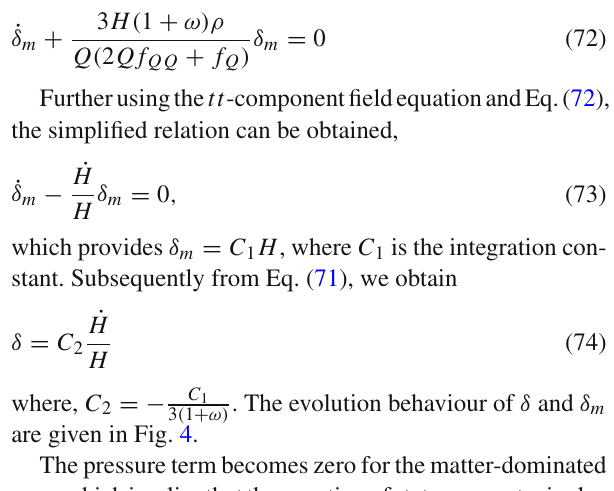
that the system comprised of two critical points, with one among them shows the stable behaviour. The point A ( 0 , 0 ) corresponds to a matter-dominated Universe, and ω ef f = 0 indicates the same that the Universe is in a matter-dominated phase, as shown in the phase space portrait also. The posi- tion B ( 0 , 1 ) corresponds to a radiation-dominated phase; the = 1 / 3 indicates the radiation-dominated era. More- ω ef f over, the deceleration parameter is positive at both points,